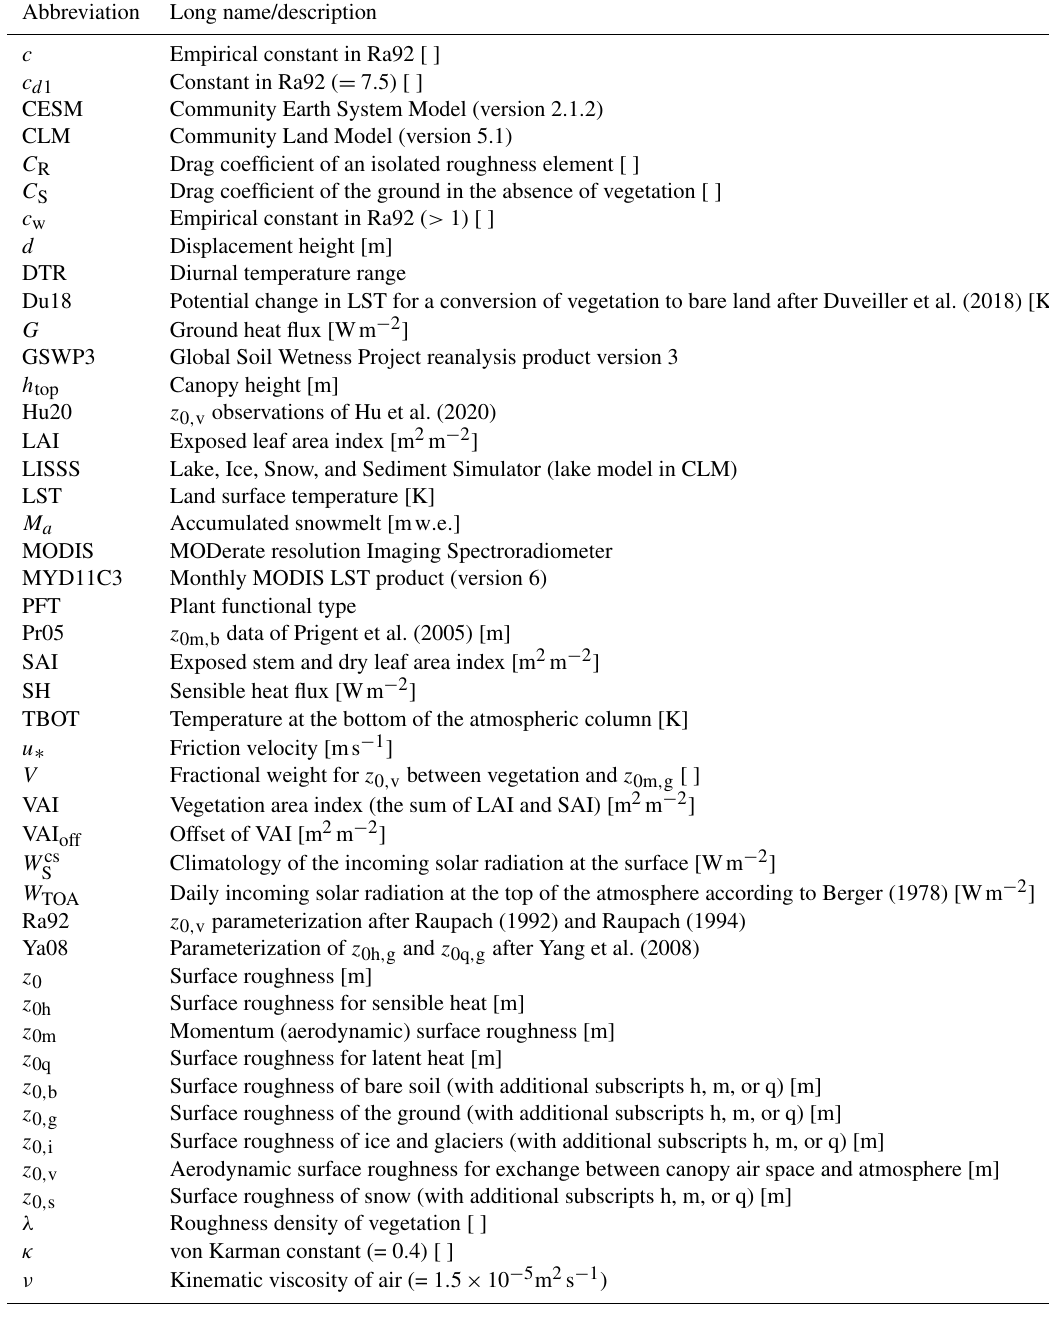
Table A2. List of abbreviations and symbols used in this study. Symbols that only appear in one equation are not